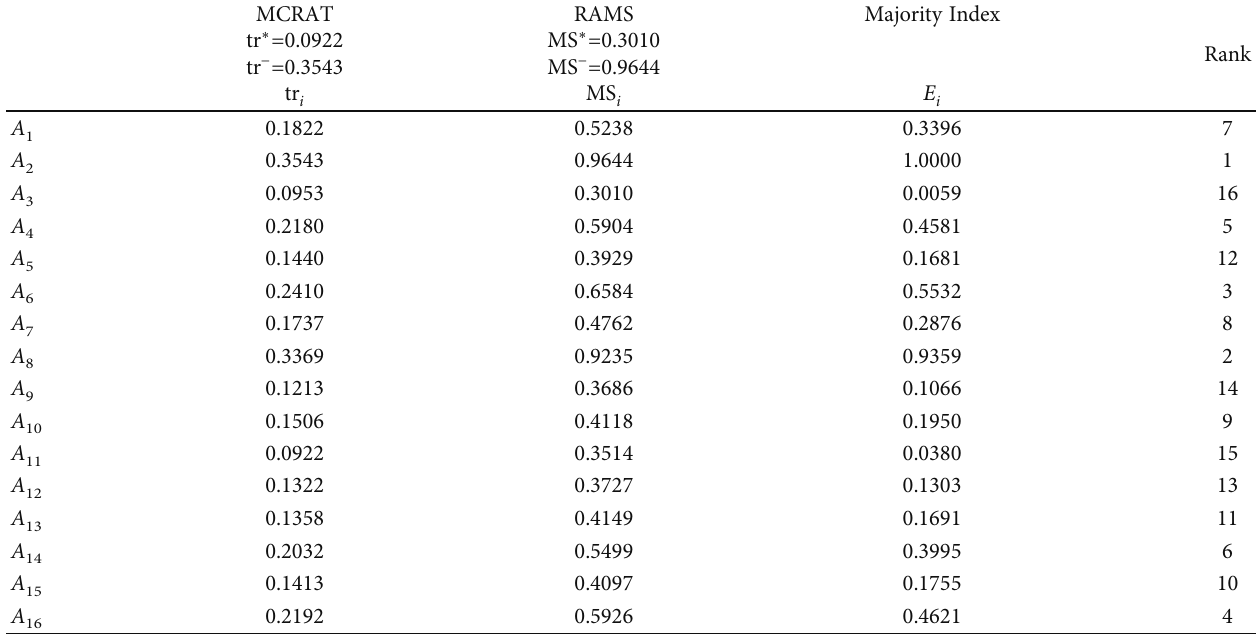
Table 10: Alternatives ranked according to RATMI